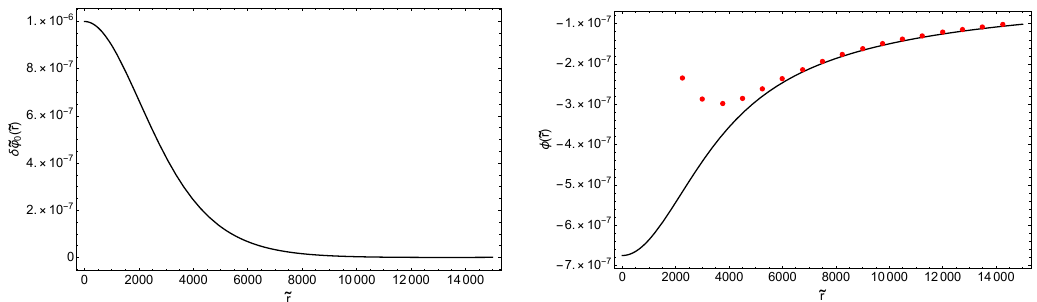
Figure 2 . Left panel : the solid line is the pro(cid:12)le of the star composed by the LVS modulus obtained numerically, with background amplitude (cid:14) ~ ’ core = 10 (cid:0) 6 . Right panel : the solid line is the Newtonian potential pro(cid:12)le obtained numerically. Red dots correspond to the last term of eq. (3.19) (cid:30) (~ r ) ’ (cid:0) ~ M (~ r ) = ~ r , showing the expected behaviour of (cid:30) at large ~ r